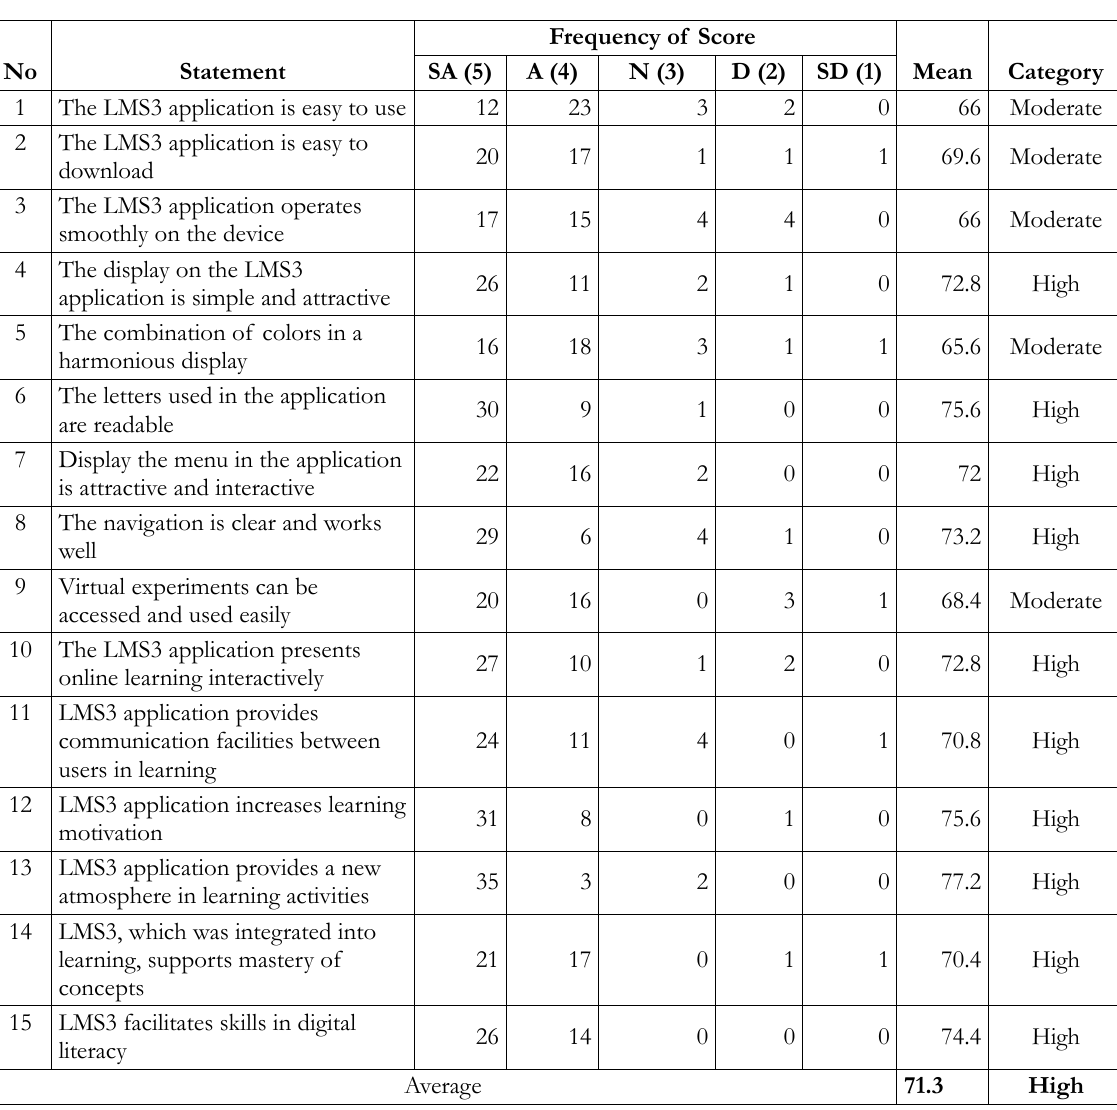
Table 5. Summary of pre-service physics teacher